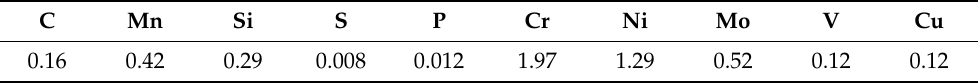
Table 2. Chemical composition (wt %) of the 15Kh2NMFA